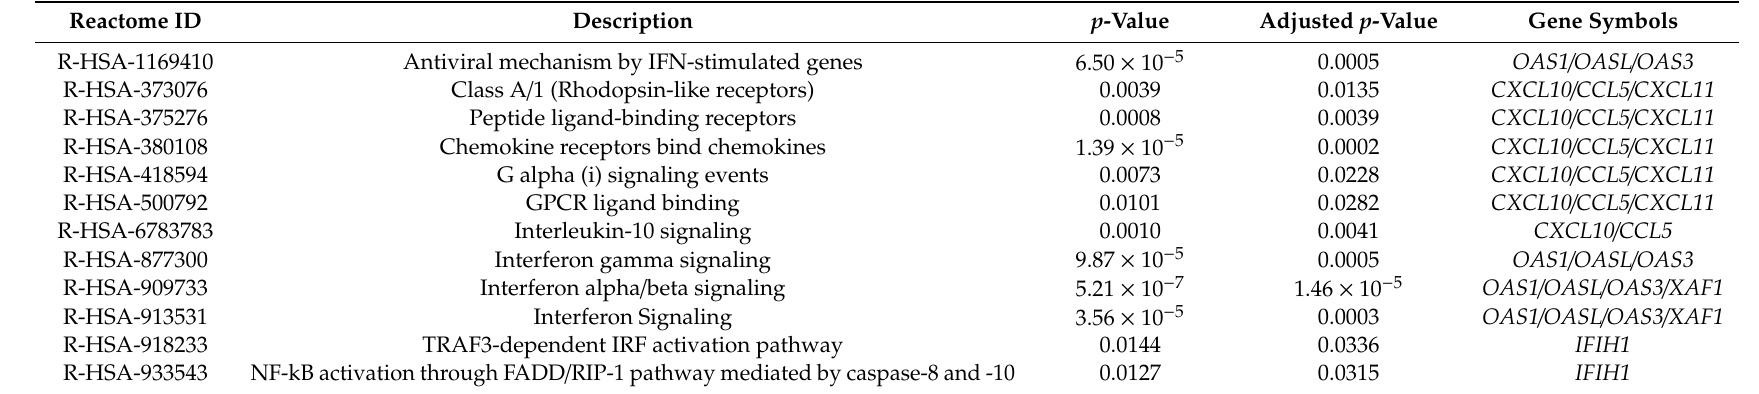
Table 4. A list of “reactome” pathways that were enriched in the meta-analysis of three RNA-Seq assays involving human neural stem cells experimentally infected in vitro with Zika virus when compared to control cells. FADD / RIP-1 (fas-associated death domain and receptor interacting protein 1), GPCR (G protein-coupled receptor), IFN (interferon), IRF (interferon regulatory factor), NF-kB (nuclear factor kappa B), TRAF3 (tumor necrosis factor receptor-associated factor